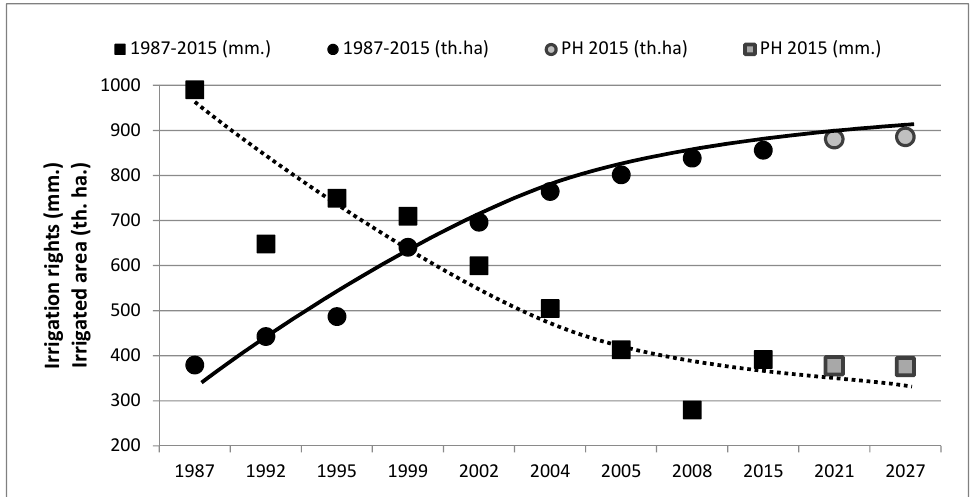
Figure 1. Average irrigation rights and irrigated area. Source: Own elaboration using data from the Guadalquivir Basin Authority and Irrigation Inventories. Adjusted polynomial trend lines are shown in order to describe the trajectory followed by irrigated area (solid trend line) and by average irrigation rights (dotted trend line).